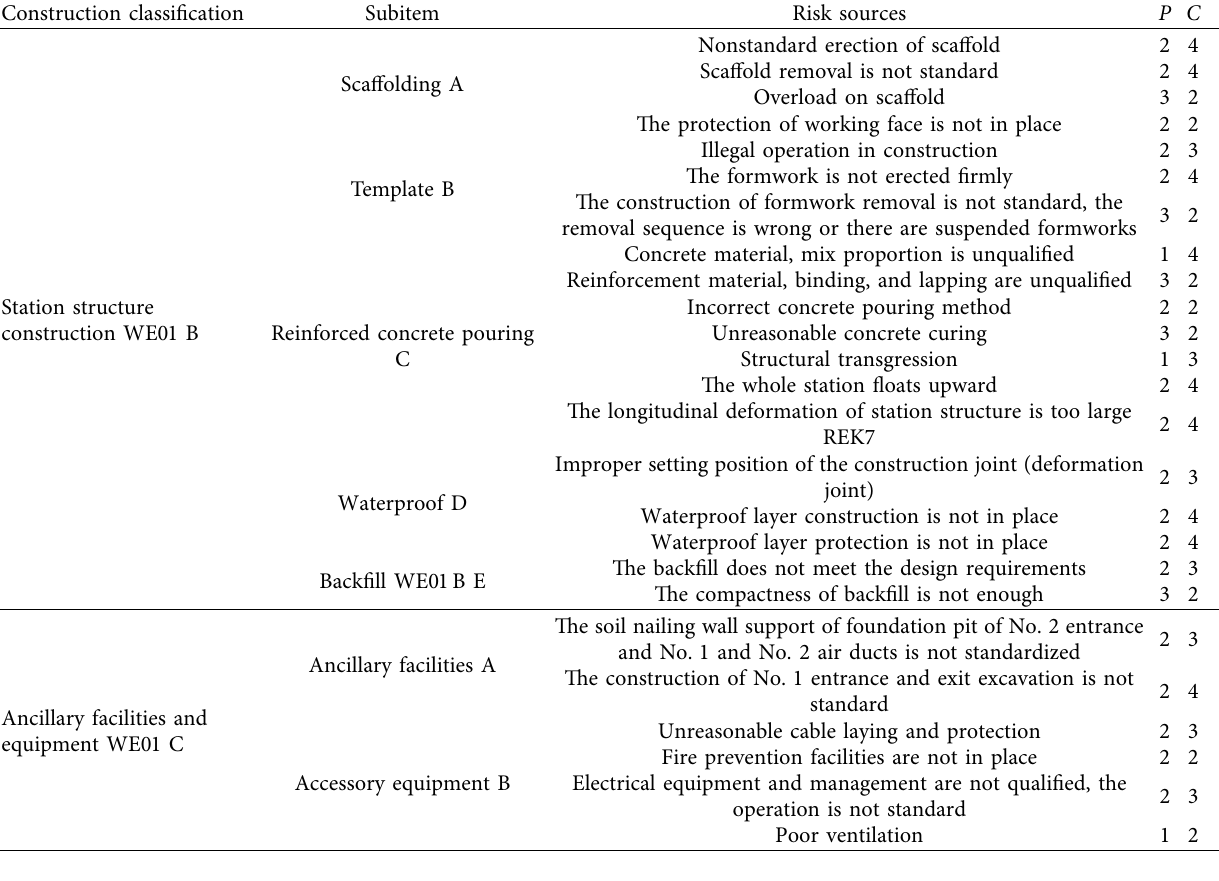
Table 17: Environmental risk list.